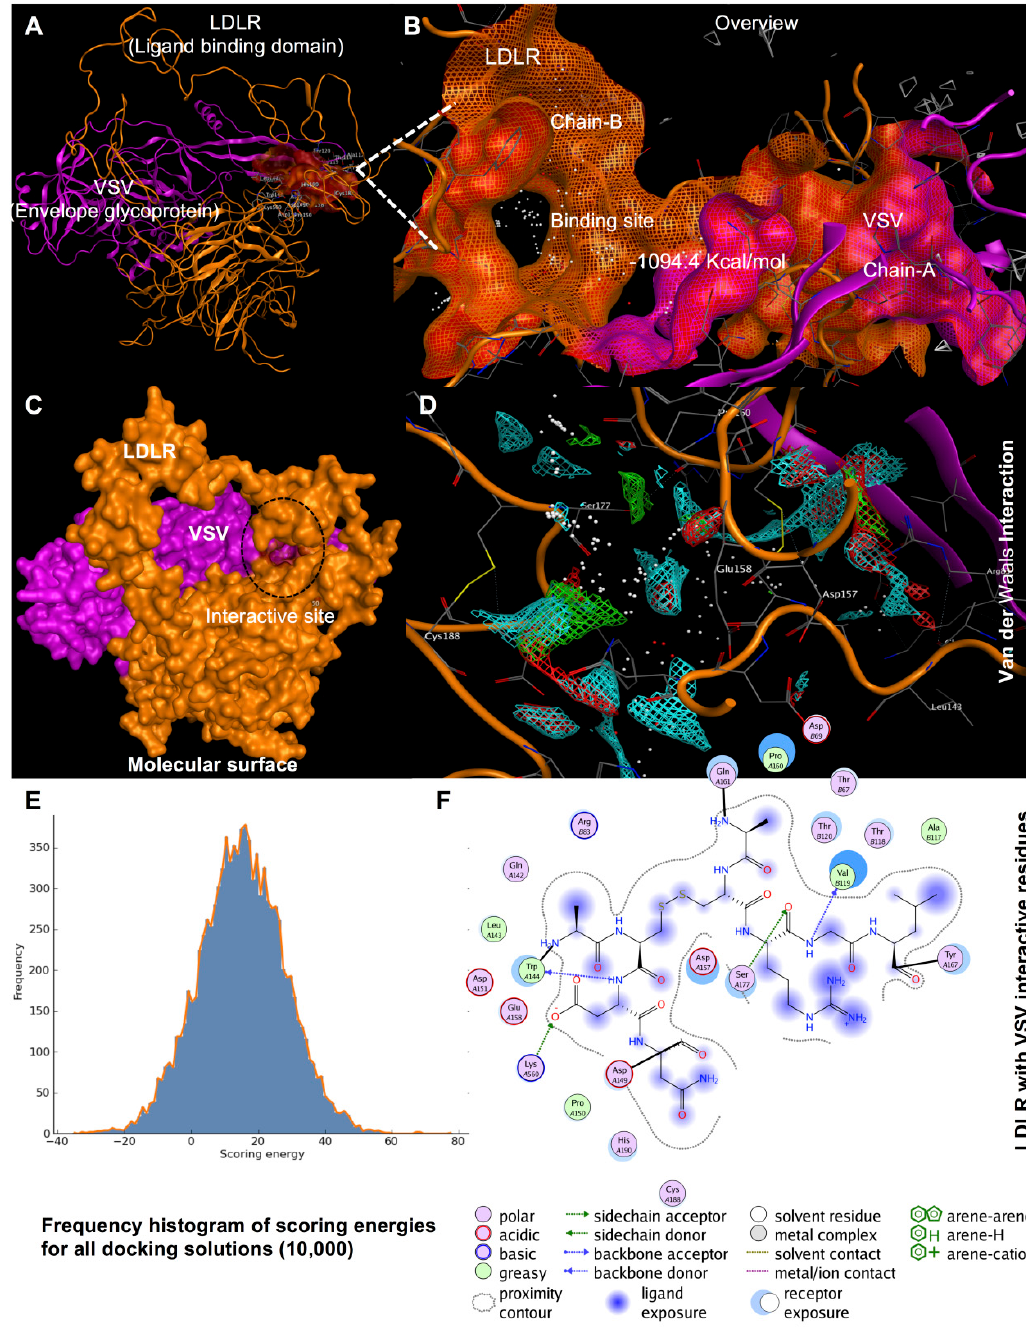
Figure 4. Model of the crystal structure of VSV and LBD interactions. Protein to protein interaction with LBD of LDLR (Chain A ) PDB ID: 1n7d (orange) and VSV envelope glycoprotein g ecto domain (Chain B ) ID: 5i2s (purple). ( B ) LBD active site as shown in the molecular surface. ( C ) LBD as shown